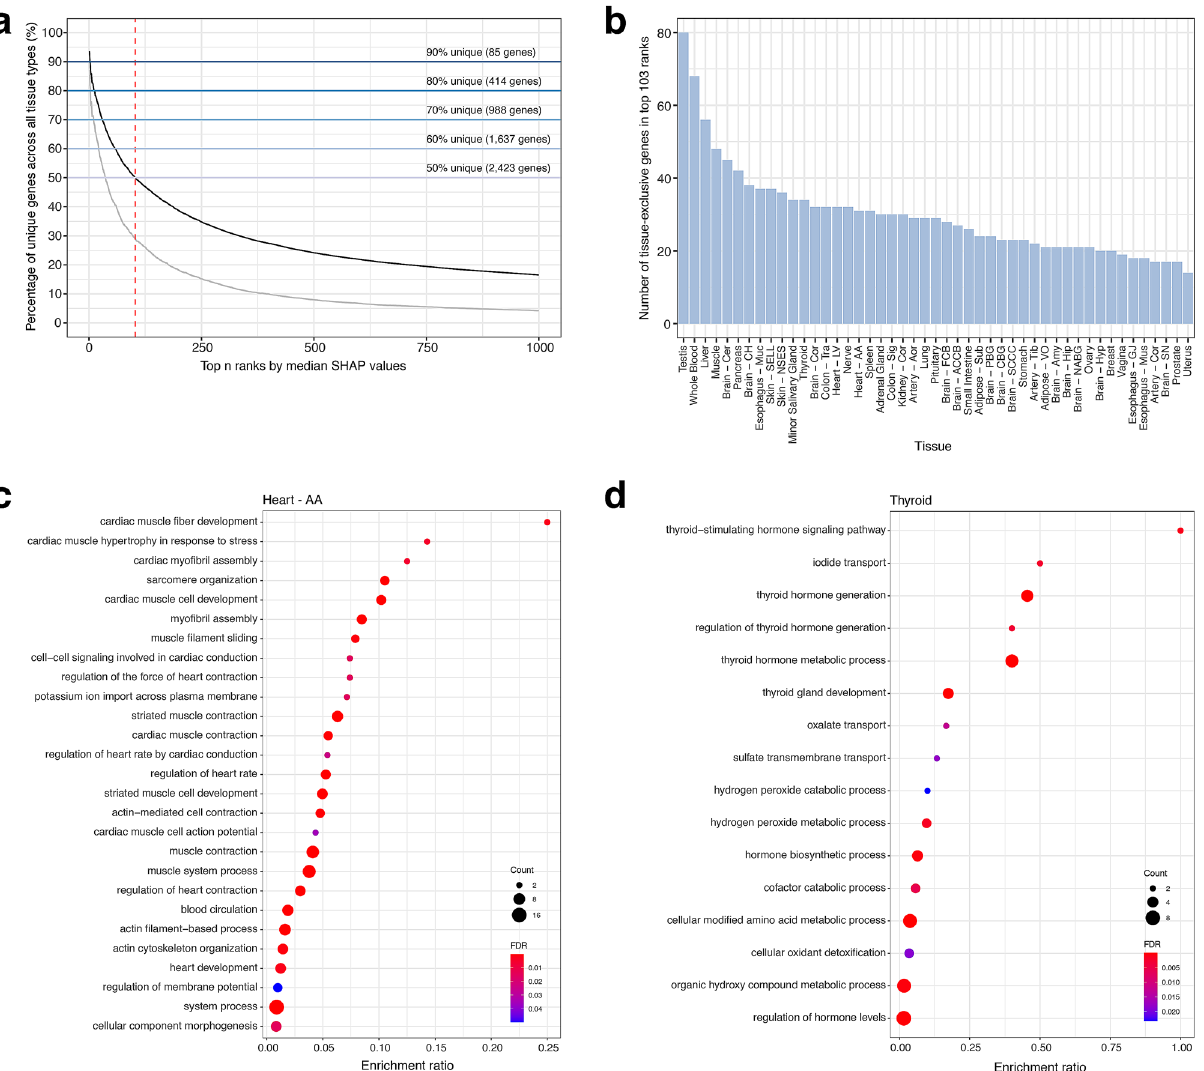
Figure 3. Identifying the most salient genes from the Convolutional neural network (CNN) model using SHapley Additive exPlanations (SHAP) for each tissue type. Median SHAP values were calculated per gene per tissue, then gene ranks were determined based on SHAP values per tissue. ( a ) Line plot showing the decreasing percentage of unique genes (black line) and tissue-exclusive genes (grey line) in expanding top n ranks of possible genes across all 47 classes (y-axis). The top 103 ranks (red dashed line) contain a total of 4,841 genes (47 classes × 103 ranks = 4,841), but some genes occur in multiple tissues, with approximately 50% of genes (2,423 genes) being unique. ( b ) The number of tissue-exclusive genes in the top 103 ranked genes per tissue type. Enriched Gene Ontology (GO) biological processes using tissue-exclusive genes for ( c ) Heart—AA and ( d ) Thyroid. Enrichment ratio was computed as the ratio of the observed gene count to background gene